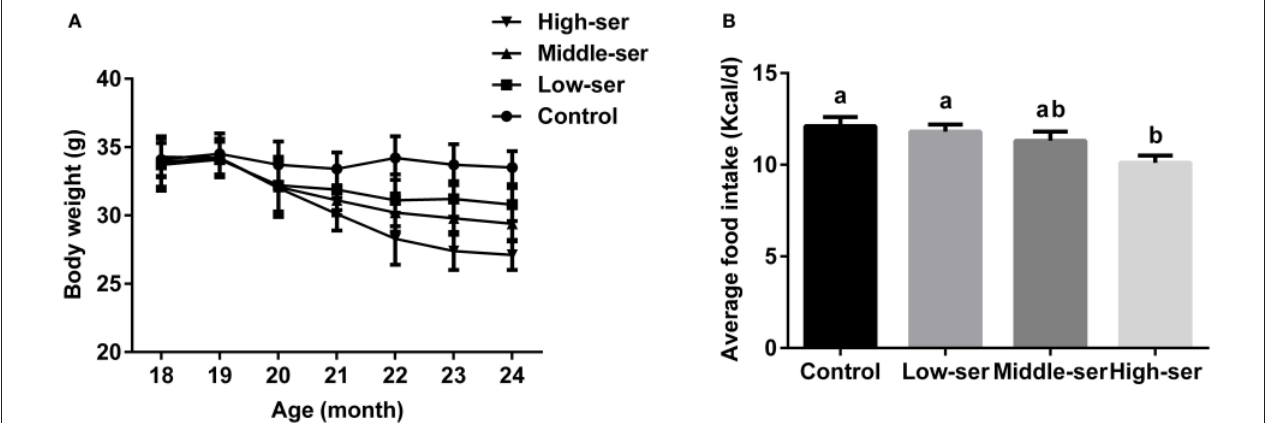
FIGURE 1 | Effects of long-term L -serine administration on body weight and food intake in aging mice. (A) Body weight; (B) average daily food intake. Control, untreated control mice; Low-ser, mice supplemented with 0.1% (wt/vol) L -serine dissolved in the drinking water; Middle-ser, mice supplemented with 0.2% (wt/vol)